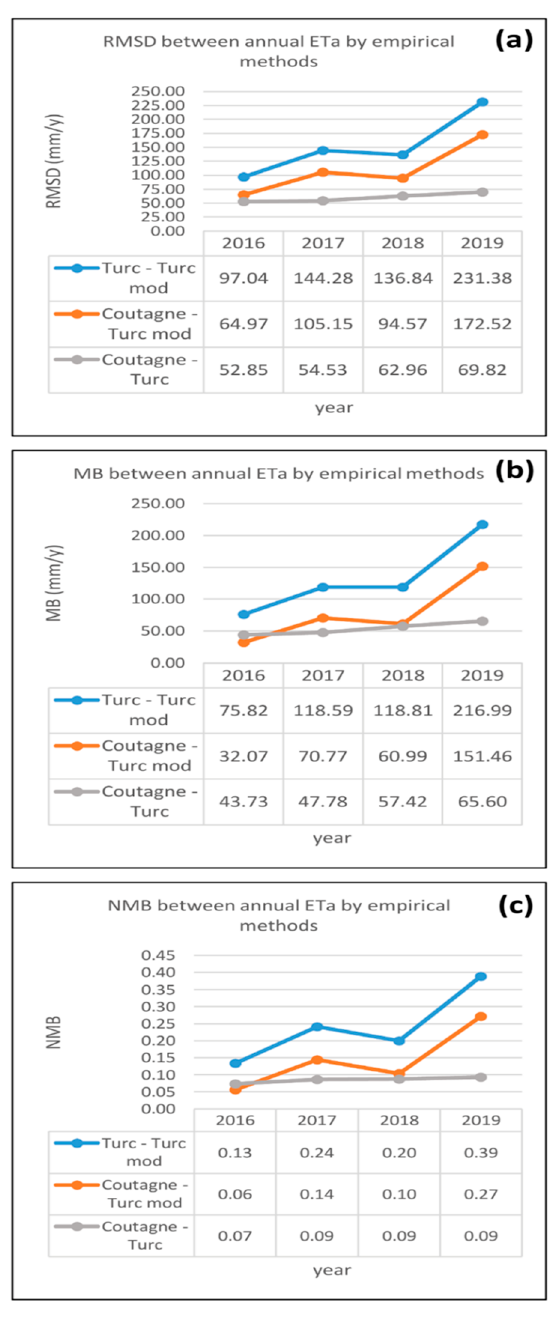
Figure 3. ( a ) RMSD, ( b ) MB, and ( c ) NMB of annual ETa estimates of empirical methods for 2016– 2019.